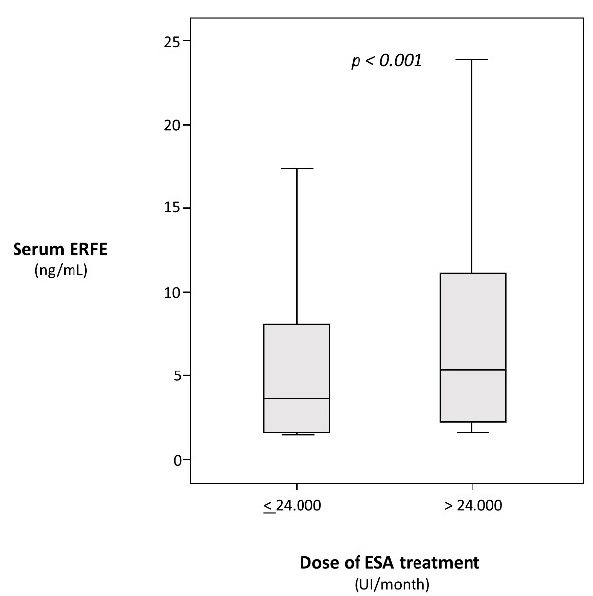
Figure 1. Serum erythroferrone (ERFE) levels below and above the median value (24.000 UI) of monthly erythropoiesis stimulating agents (ESA) dose.